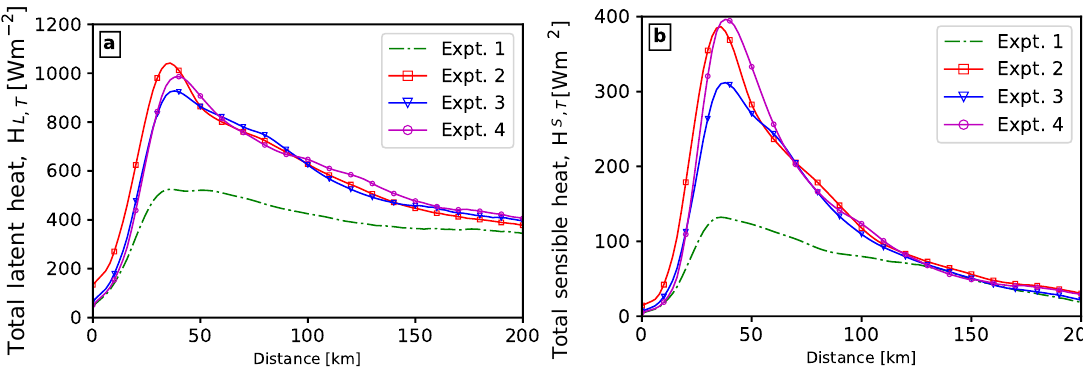
Figure 15. Radial distribution of the azimuthal averaged total (a) latent heat flux and (b) the sensible heat flux at 00:00UTC on 3 July